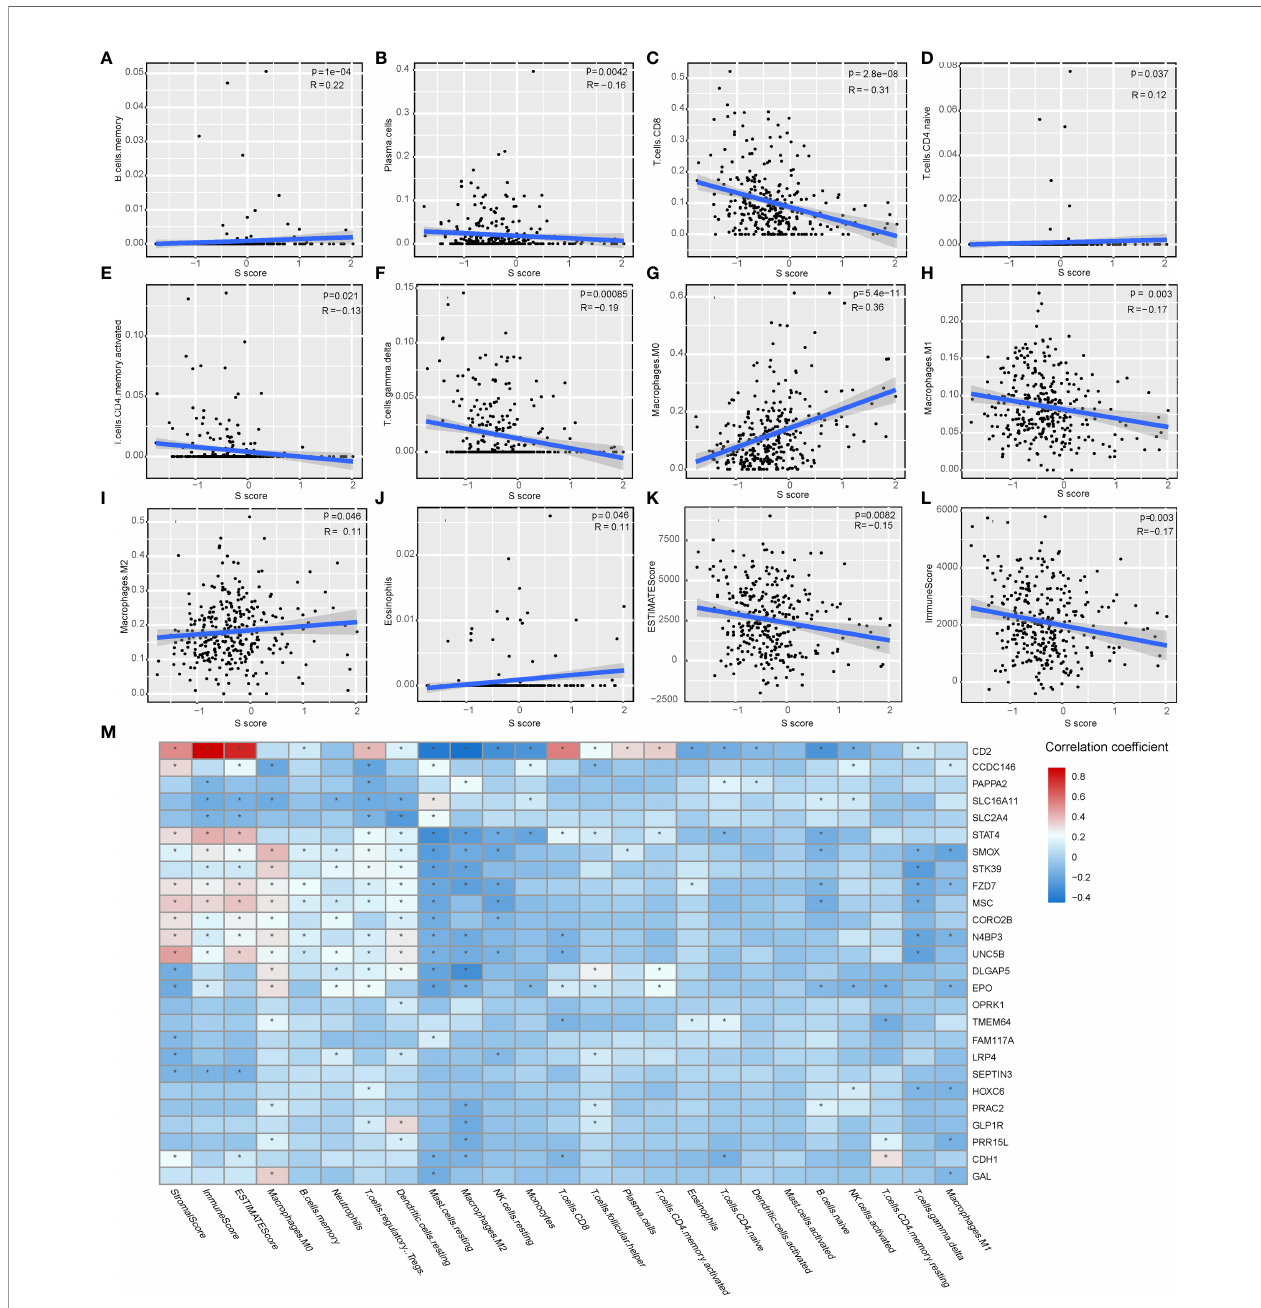
FIGURE 6 | The correlation of the S score and immune features in HCC. (A – J) The correlation of S score and IC, including memory B cells (A) , plasma cells (B) , CD8 T cells (C) , naive CD4 T cells (D) , activated memory CD4 T cells (E) , gamma delta T cells (F) , M0 Macrophages (G) , M1 Macrophages (H) , M2 Macrophages (I) , and Eosinophils (J) . (K – L) The correlation of S score and immune scores, including Immune Score (K) and ESTIMATE Score (L) . (M) Detailed information of the correlation between the S score component genes and immune features. The color bar represents correlation coef fi cients. *P <